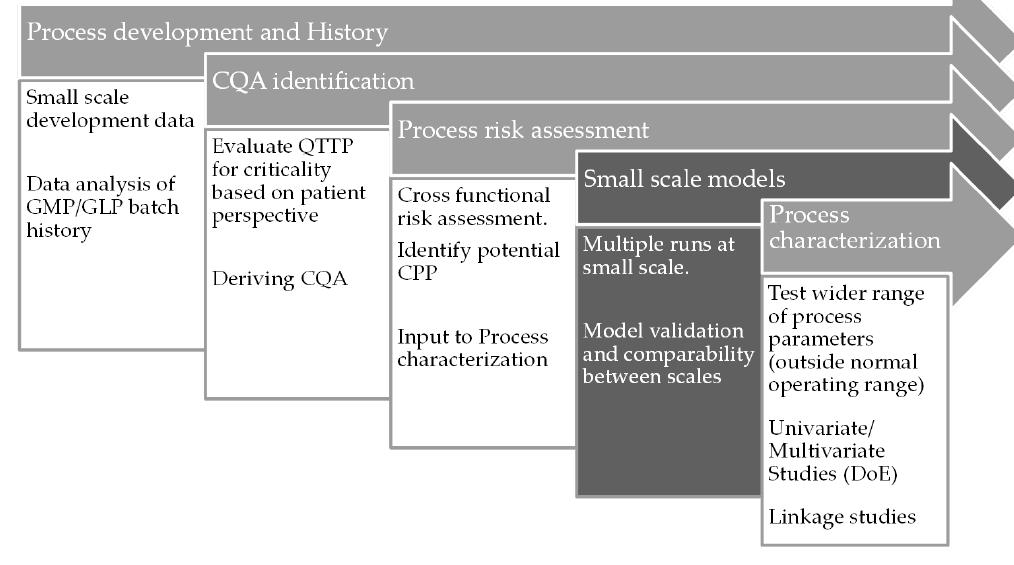
Figure 13. Missing link in process development [13].